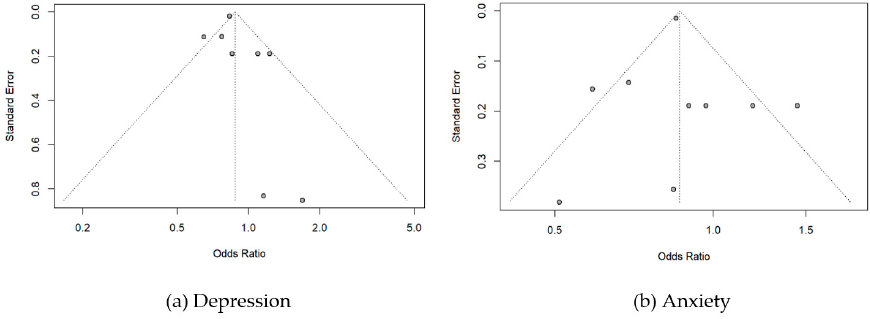
Figure 5. Funnel plots for publication bias of odds ratio on ( a ) Depression and ( b